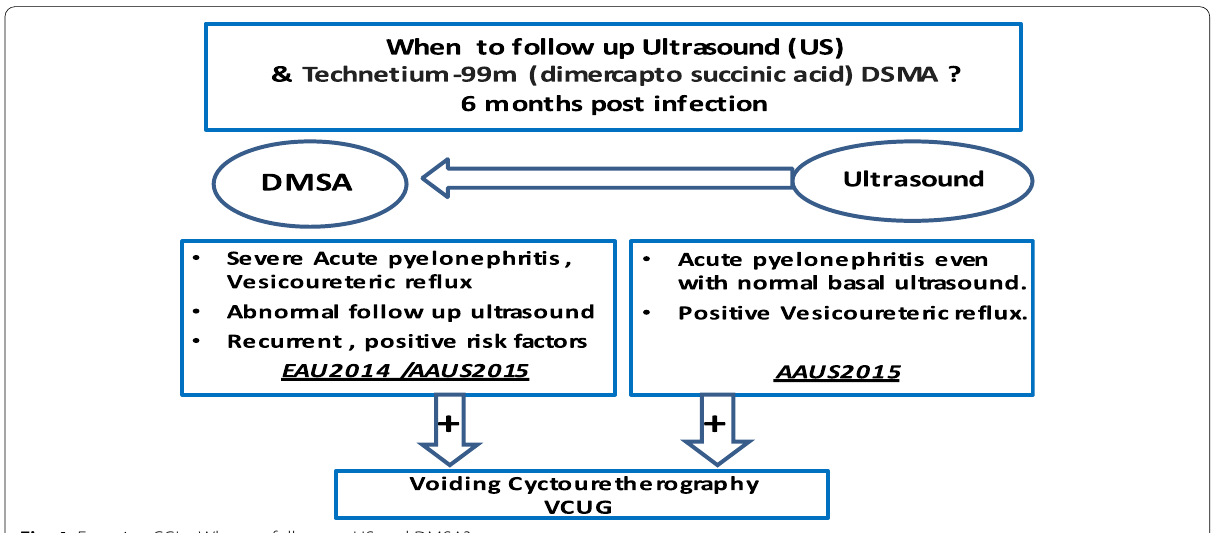
Fig. 4 Egyptian CGLs. When to follow-up US and